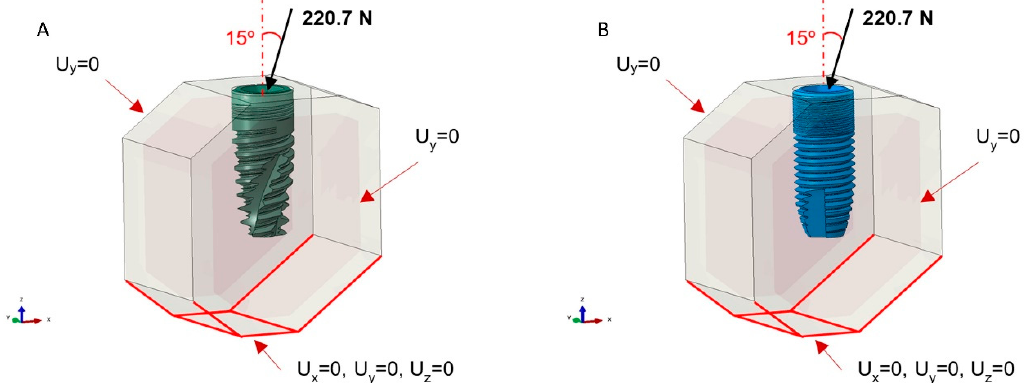
Figure 1. Boundary conditions and loading state for the M-12 implant model ( A ). Boundary conditions and loading state for the Astra implant model ( B ). The point of application of the load is 5 mm above the implant, affecting the prosthetic abutment, although the implant platform appears directly in the diagram.